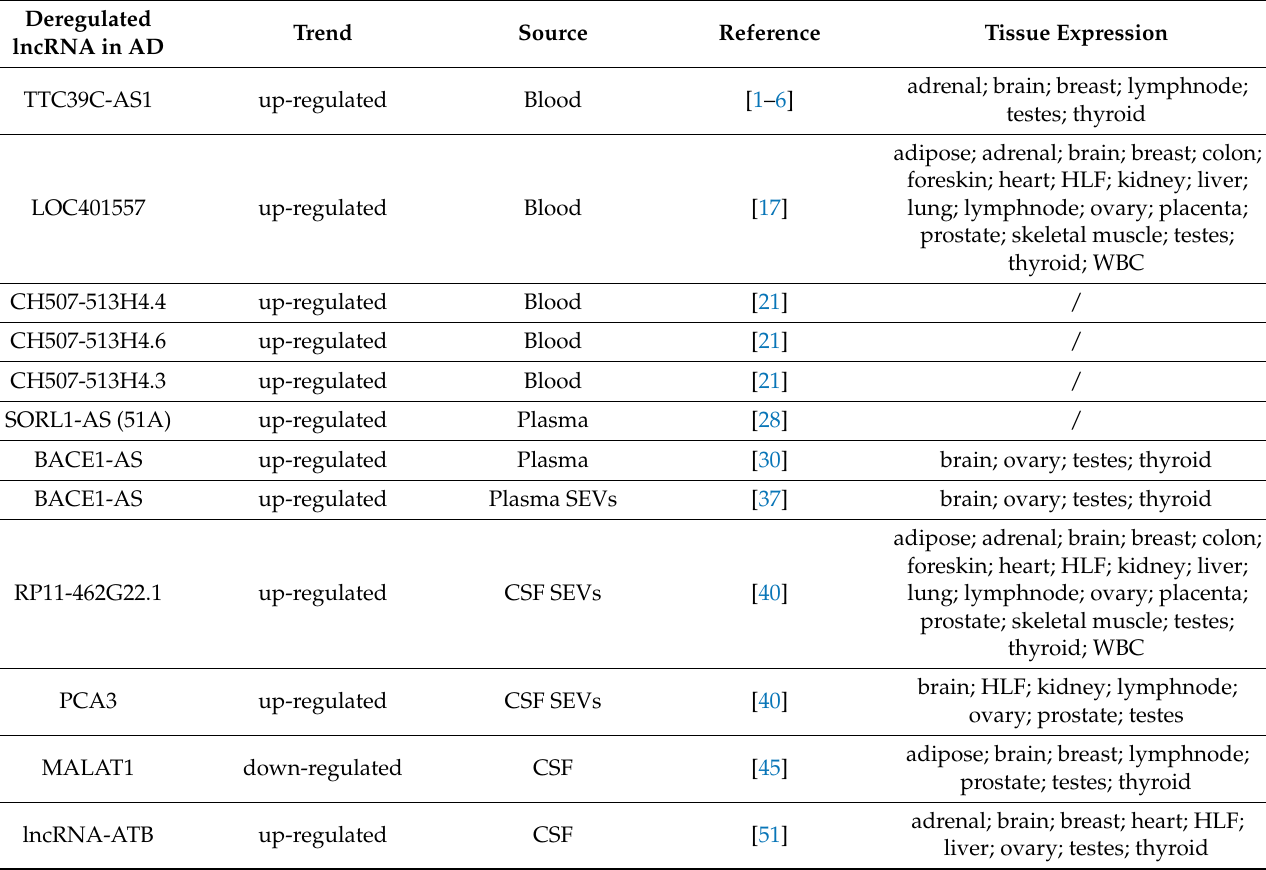
Table 1. Deregulated lncRNA in peripheral tissue of AD